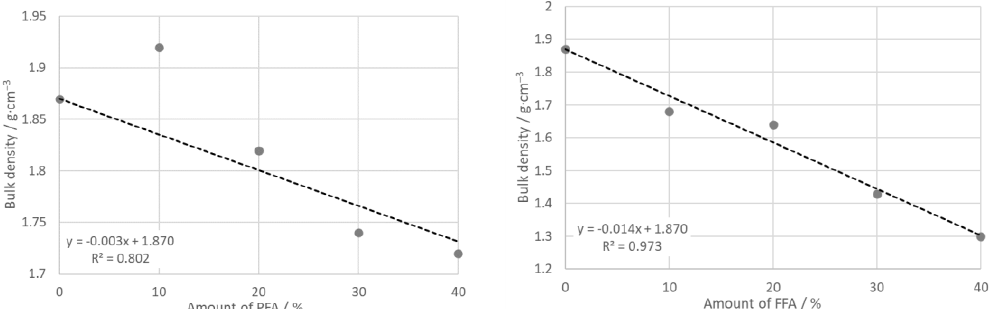
Figure 7. The bulk density of PF ( left ) and FF ( right ) samples (measured at the room temperature after firing at 1100 °C).